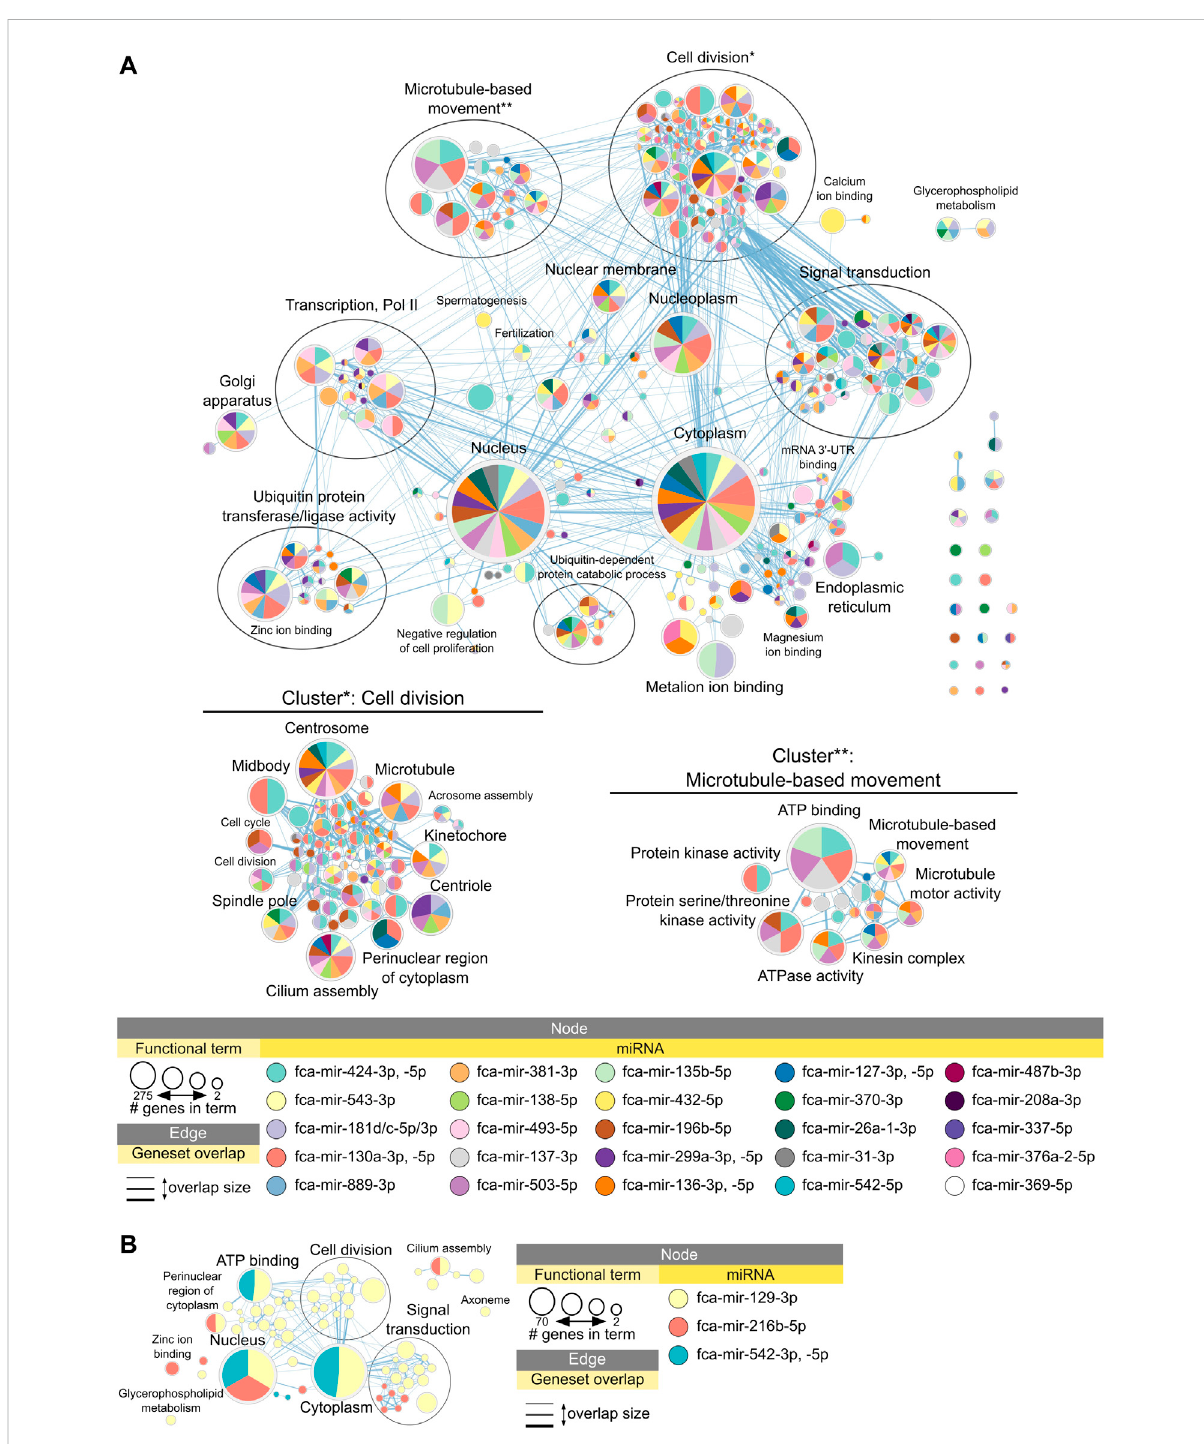
FIGURE 5 Functional terms and pathways potentially inhibited by miRNAs in juvenile testes. Enrichment map displays enriched gene-sets based on upregulated mRNA targets for each downregulated miRNA in (A) adult vs. early juvenile testis, i.e., enriched in adult compared to early juvenile, and (B) adult vs. late juvenile testis, i.e., enriched in adult compared to late juvenile. Interactive networks including networks of each functional cluster with corresponding data tables are available in Supplementary Data Sheet